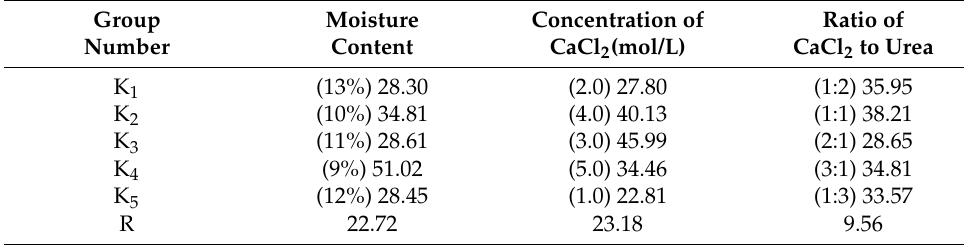
Table 4. The orthogonal experiment analysis table.